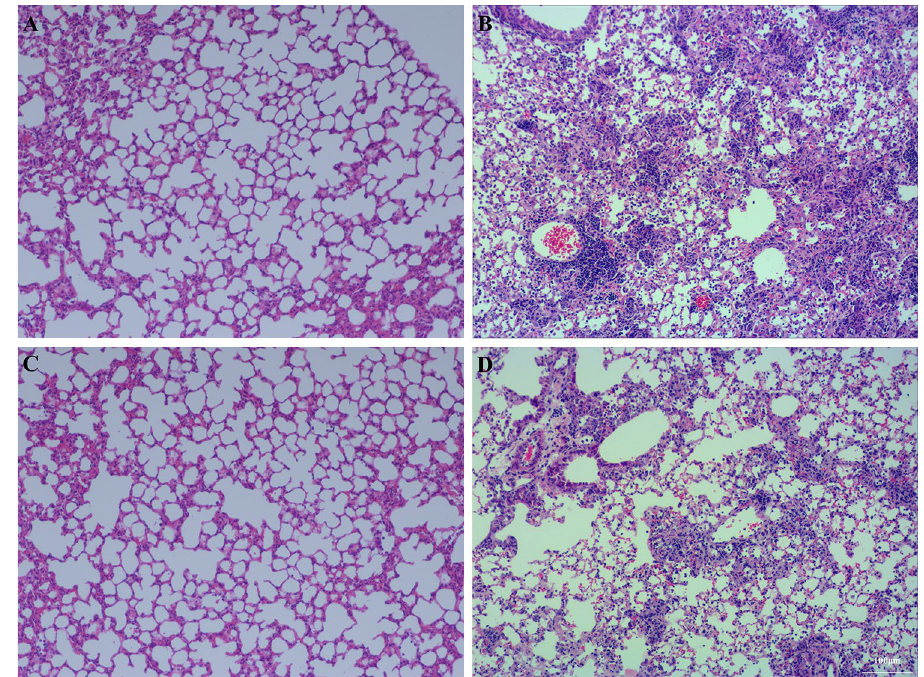
Figure 2. A photomicrograph of lung parenchyma used for morphological analysis. ( A ) Con group, ( B ) LPS group, ( C ) Ex group, ( D ) Ex + LPS group [( A – D ) × 100